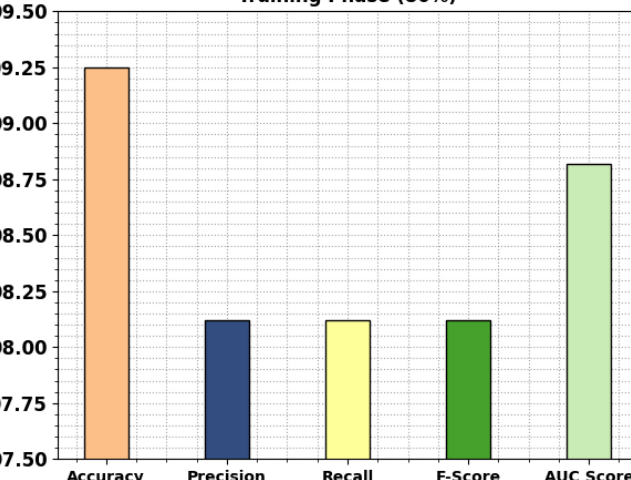
Figure 5. Average outcomes of MPADL-LC3 algorithm on 80% of TRS.